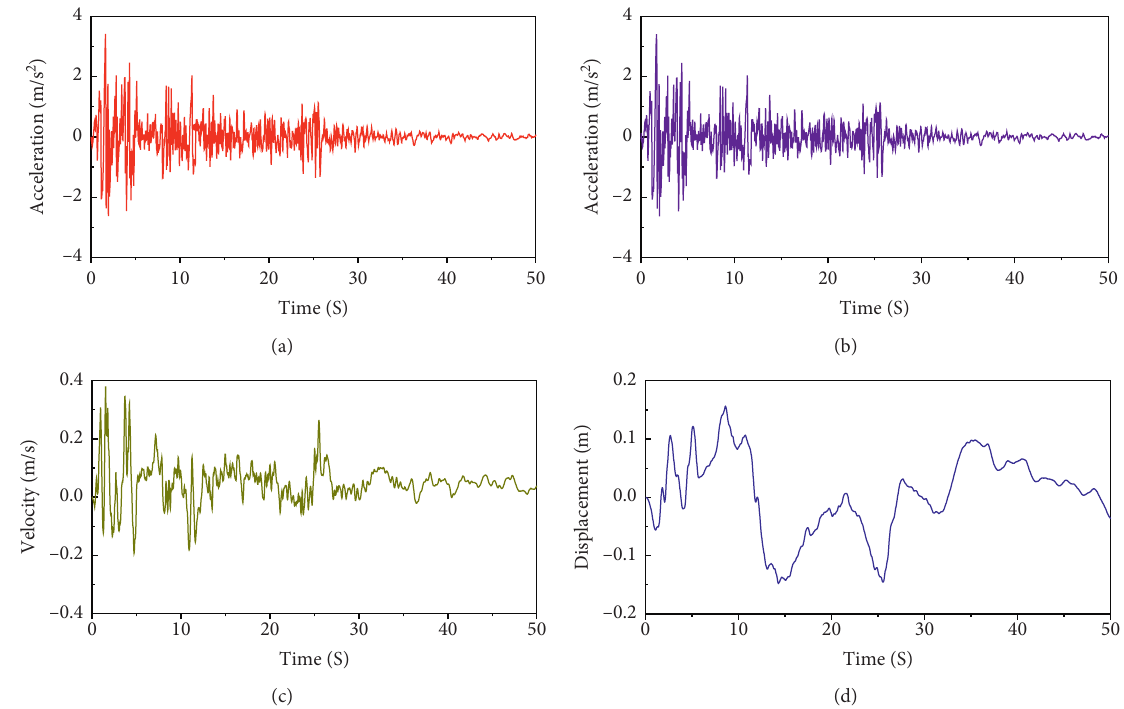
Figure 6: Acceleration, velocity, and displacement time histories of the seismic wave. (a) Original acceleration time history of the seismic wave. (b) Modified acceleration time history of the seismic wave. (c) Modified velocity time history of the seismic wave. (d) Modified displacement time history of the seismic